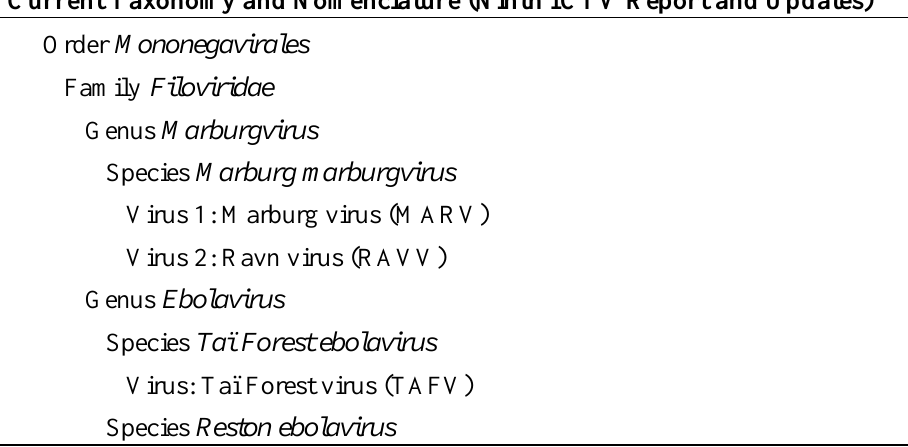
Table 1. Summary of the current filovirus taxonomy endorsed by the 2012–2014 ICTV Filoviridae Study Group and accepted by the ICTV